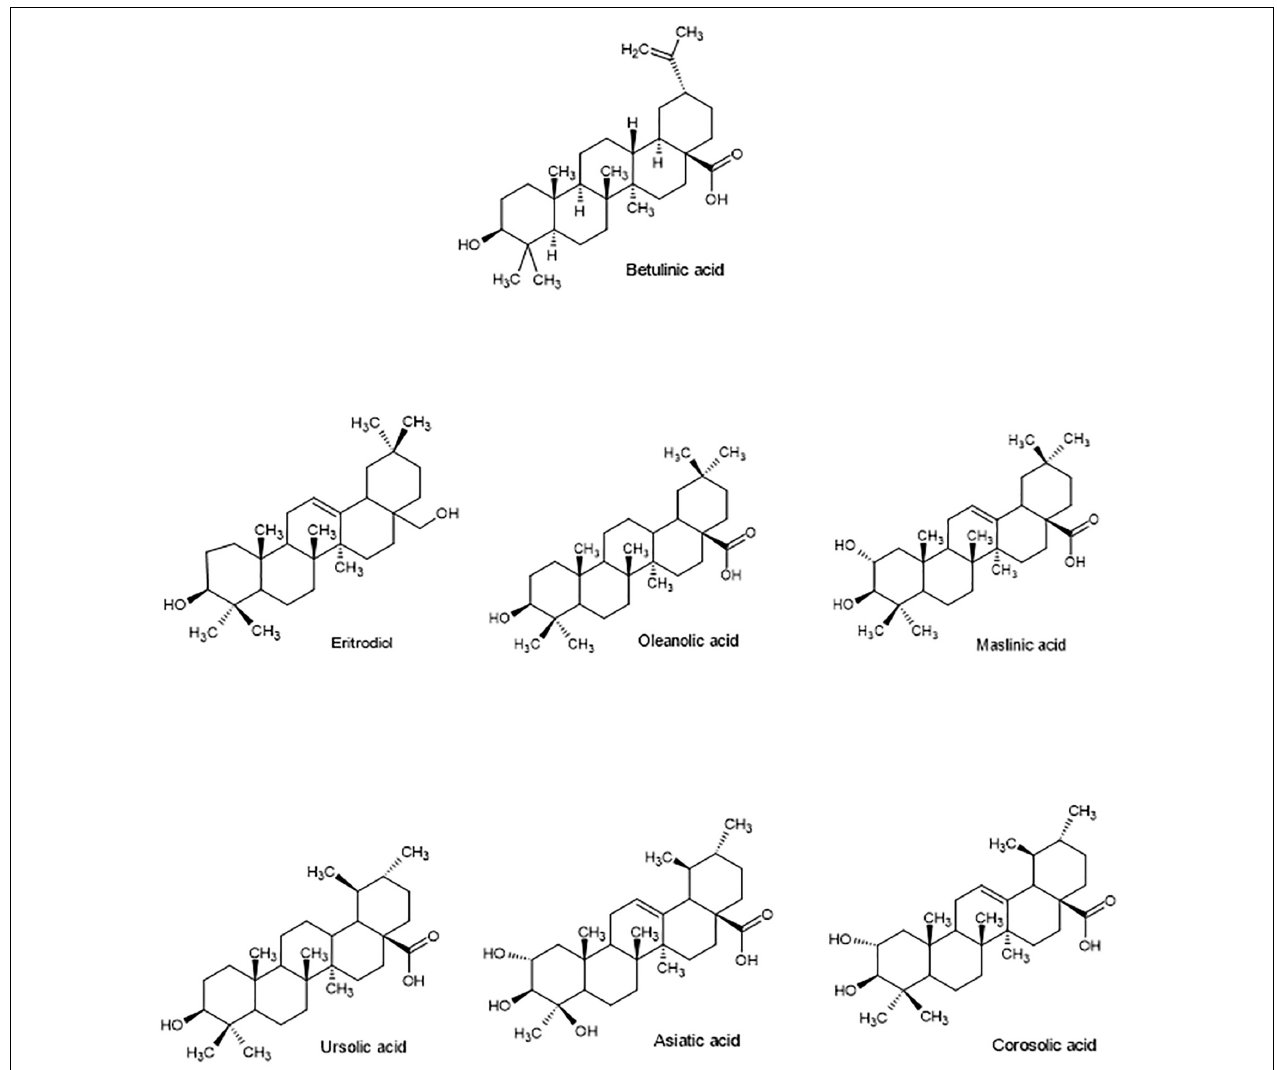
FIGURE 4 | Structure of main bioactive pentacyclic triterpenes of lupine, oleanane and ursane subtypes.